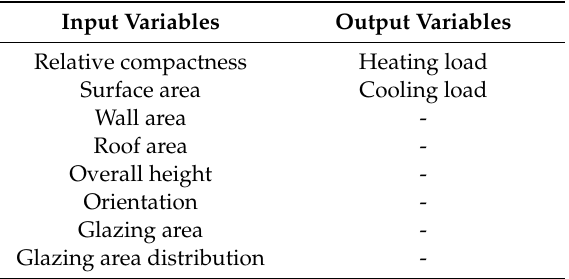
Table 2. Input and output variables for the energy e ffi ciency problem.